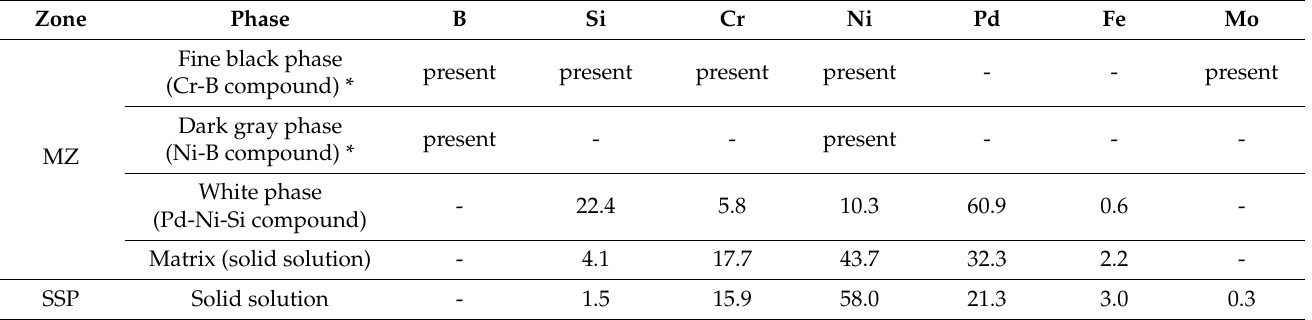
Table 2. Composition of constituents in MZ and SSP zones in at. % (SEM/FESEM–EDS